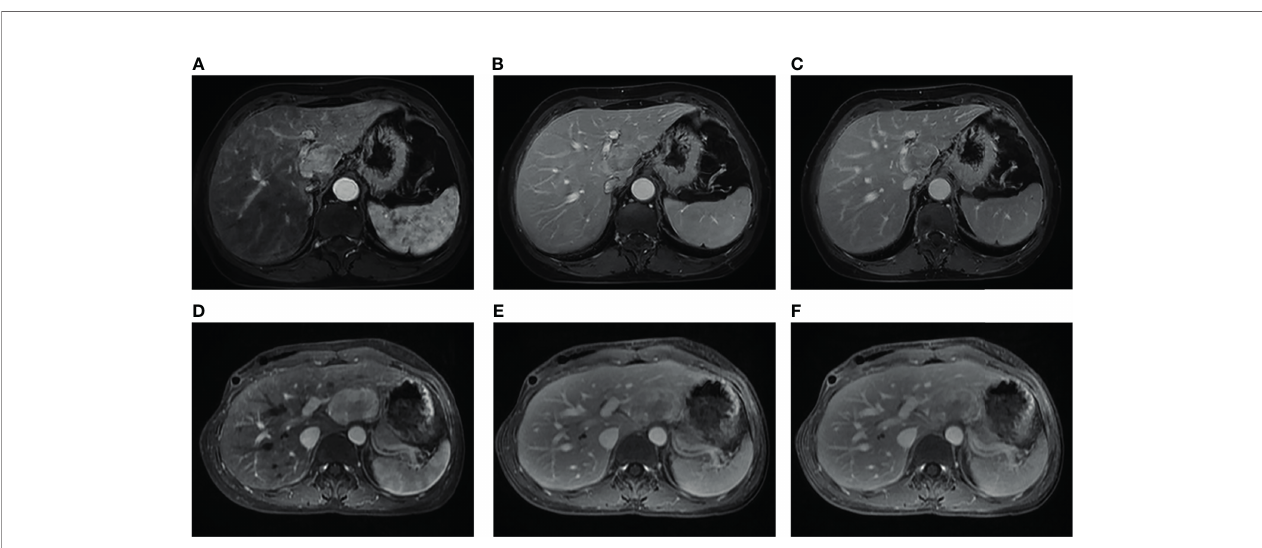
FIGURE 6 | Two representative cases: case 1 (A – C) , a 65-year-old female without chronic hepatitis B virus (HBV) infection, and case 2 (D – F) , a 36-year-old female with chronic HBV infection. These two cases were both misdiagnosed as hepatocellular carcinoma by two radiologists, whereas the model output was consistent with the correct diagnosis of fat-poor